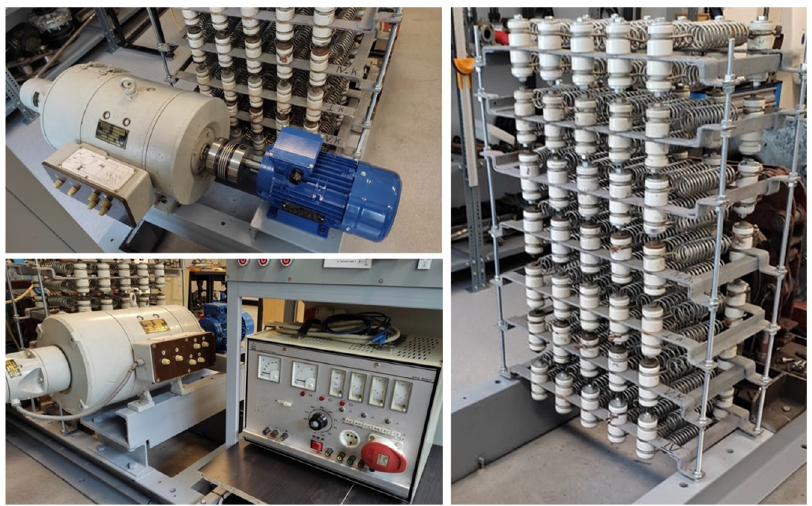
Figure 13. Photos of the AC power source and the load resistor.